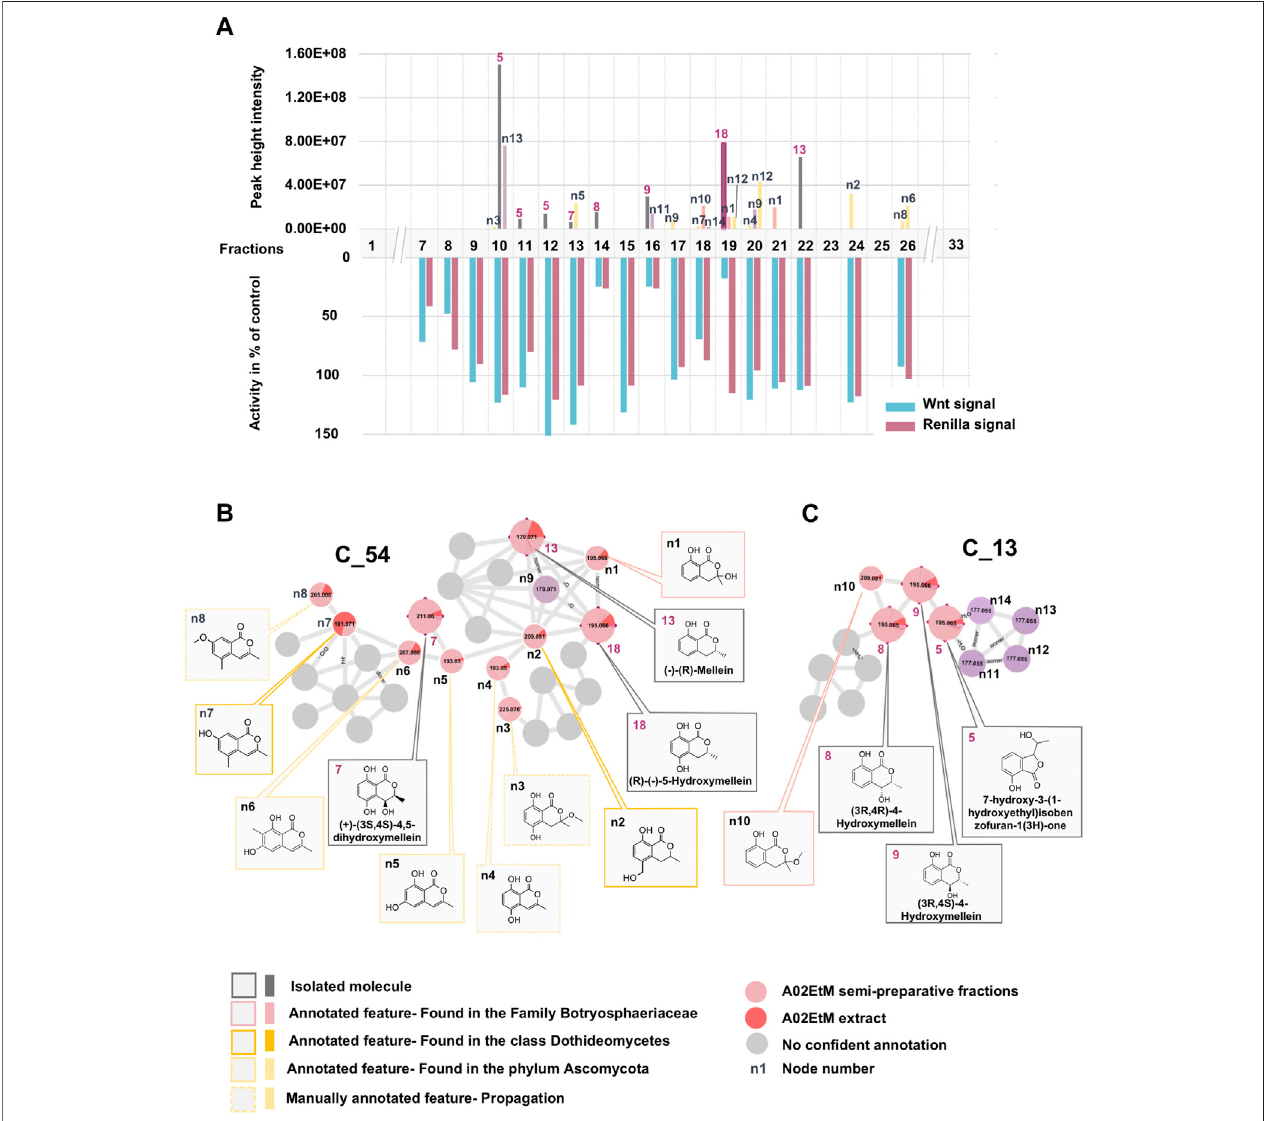
FIGURE6 | Detailed viewof thefraction composition and bioactivityacrossall fractions containing isocoumarins analogs. (A) Histogram represented as afunction of the 33 collected fractions showing the peak height intensity of the related putative analogs and their occurrence in the fractions. Associated is the activity of each fraction:inblue, activity onWntsignal (inhibition activity), inpink, effect onRenilla signal(cytotoxicity). Fraction F19isconsidered asspeci fi callyactive since itinhibitsWnt signaling without having an impact on Renilla signaling. (B) Cluster C_54 containing node 18 corresponding to compound 18 , isolated (7, 13) and hypothetical (n1 – 8) analogs. (C) Cluster C_13 containing isolated (5, 8, 9) and hypothetical (n10 – 14) analogs.